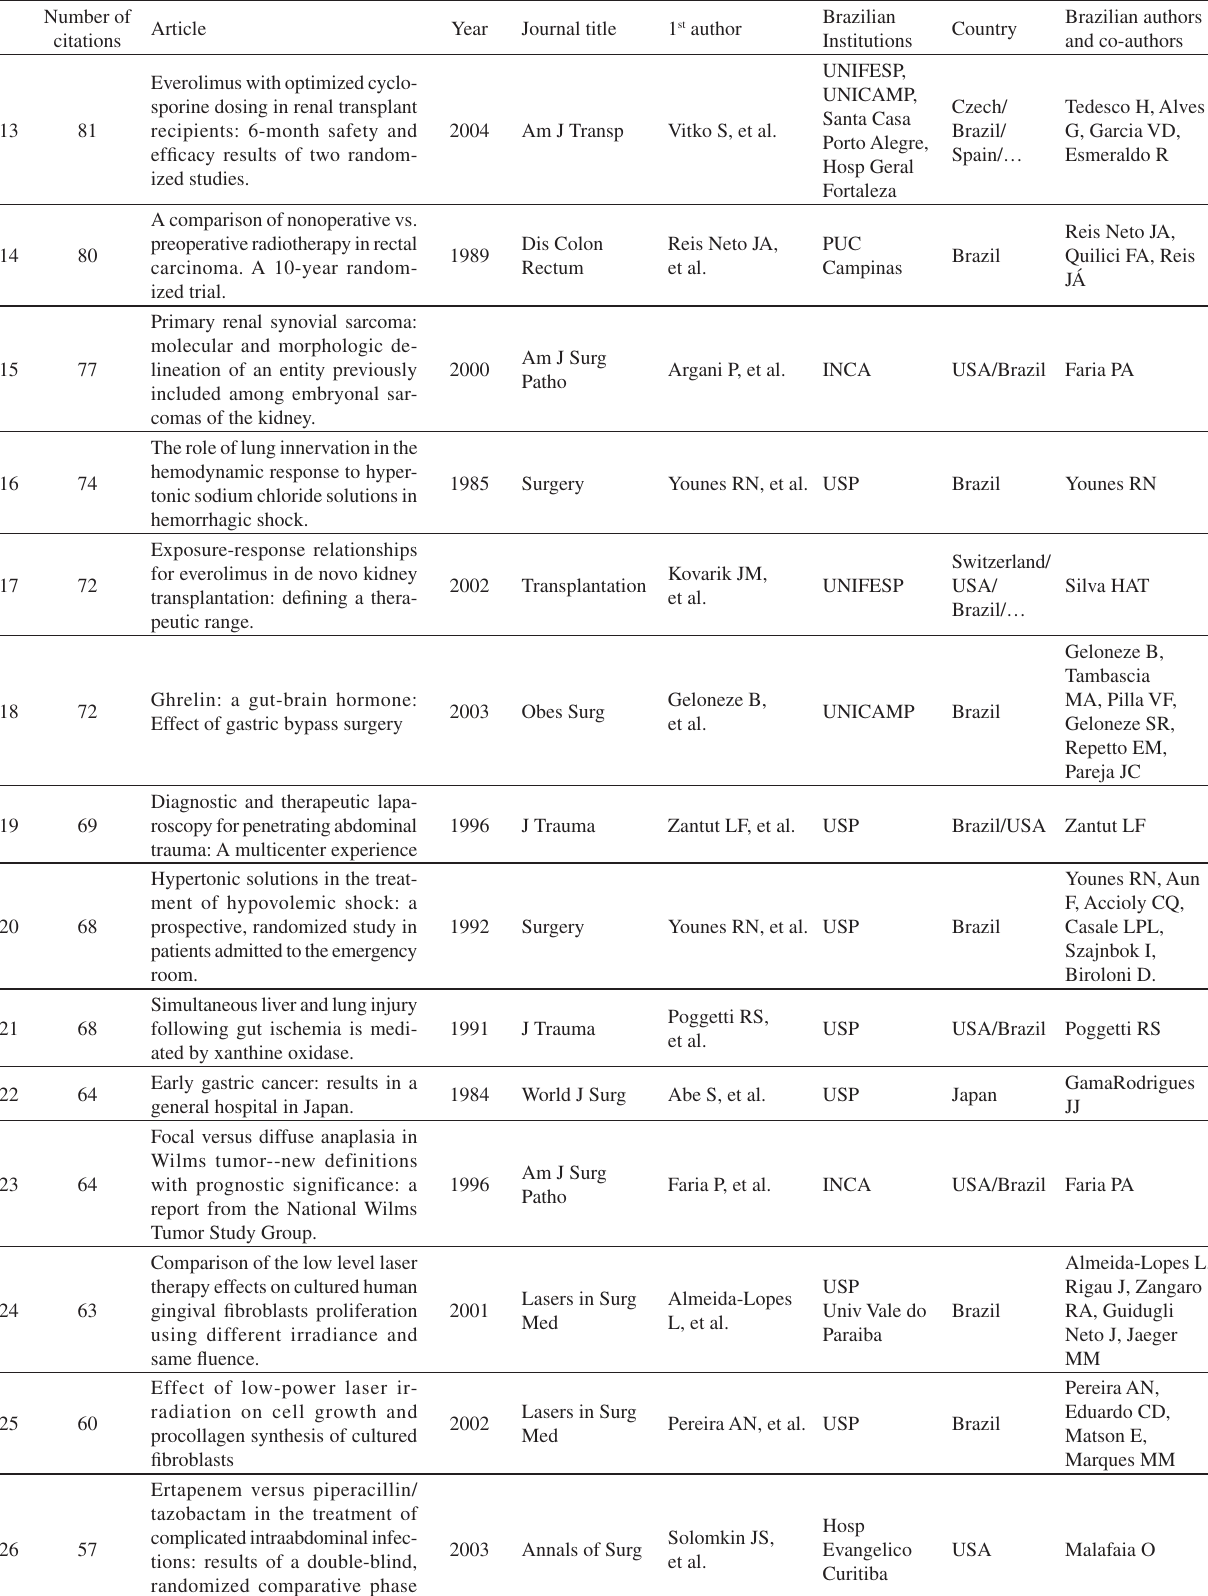
Table 5 - List of the Brazilian thirty most cited articles in general surgery, during the period of 1970-2009 years.